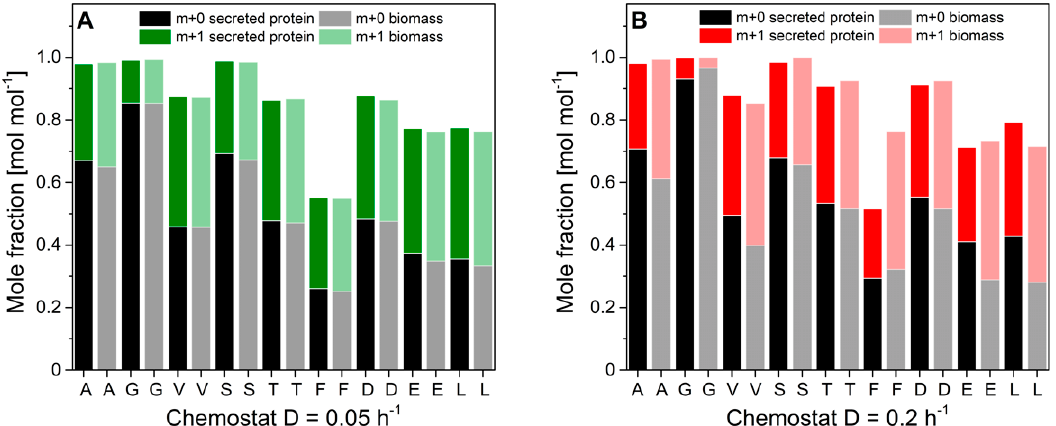
Figure 8. Molar fractions of m + 0 and m + 1 isotopomers in proteinogenic amino acids from hydrolyzed biomass and hydrolyzed secreted protein from H. polymorpha RB11 conphys cultivated at dilution rates ( A ) D = 0.05 h − 1 and ( B ) D = 0.2 h − 1 . Cells were grown in aerobic continuous glucose-limited chemostats with 100% 1- 13 C glucose as the sole carbon source. (A = alanine, G = glycine, V = valine, S = serine, T = threonine, F = phenylalanine, D = aspartate, E = glutamate, L = leucine).